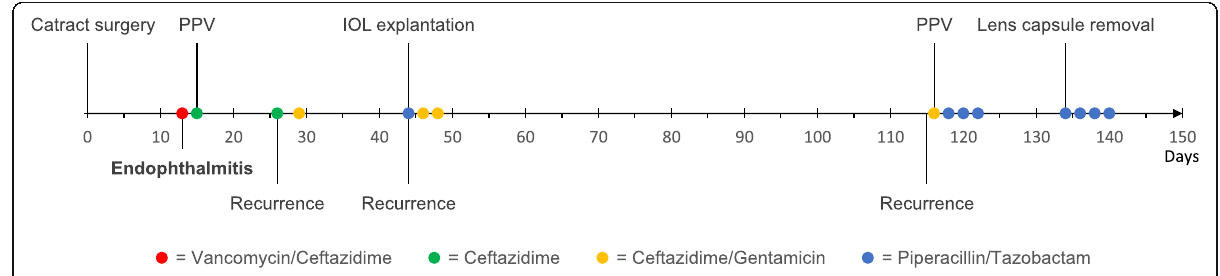
Fig. 1 Timeline of important clinical events and treatments in Case 1 from days 0 to 150 after cataract surgery. The colored dots indicate intravitreal antibiotic injections. PPV: Pars plana vitrectomy. IOL: Intraocular